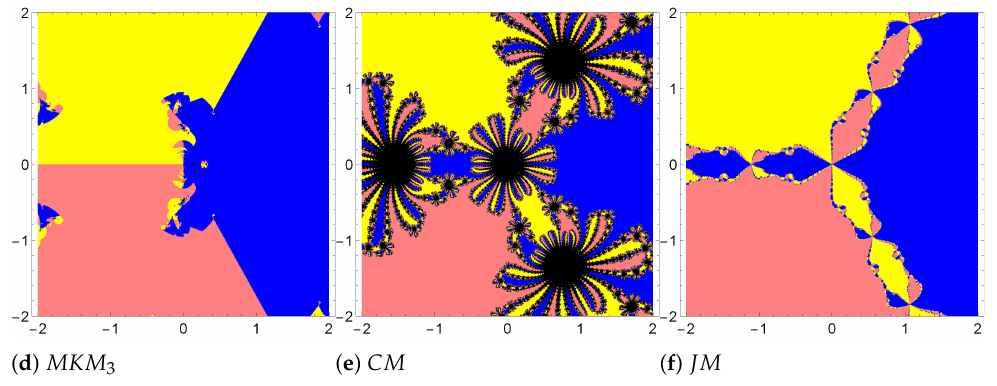
Figure 4. Dynamical planes of new and existing methods for Example 6.